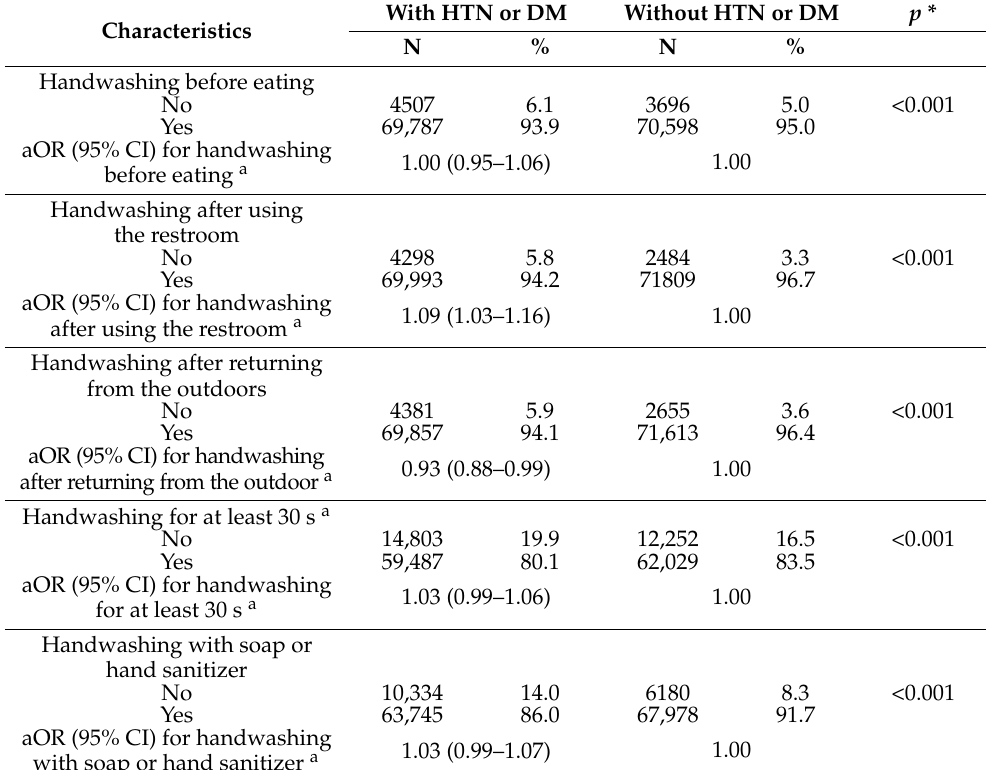
Table 3. Hand hygiene practices during the COVID-19 pandemic among people with HTN and DM compared to controls.